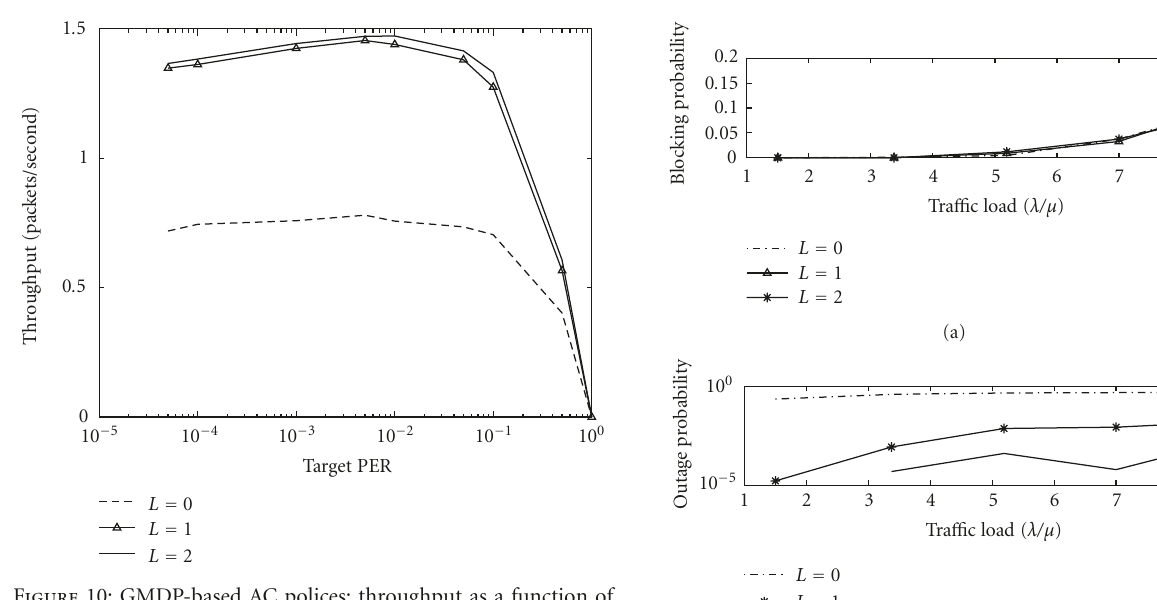
= ρ and L 1 = L 2 . 1 2